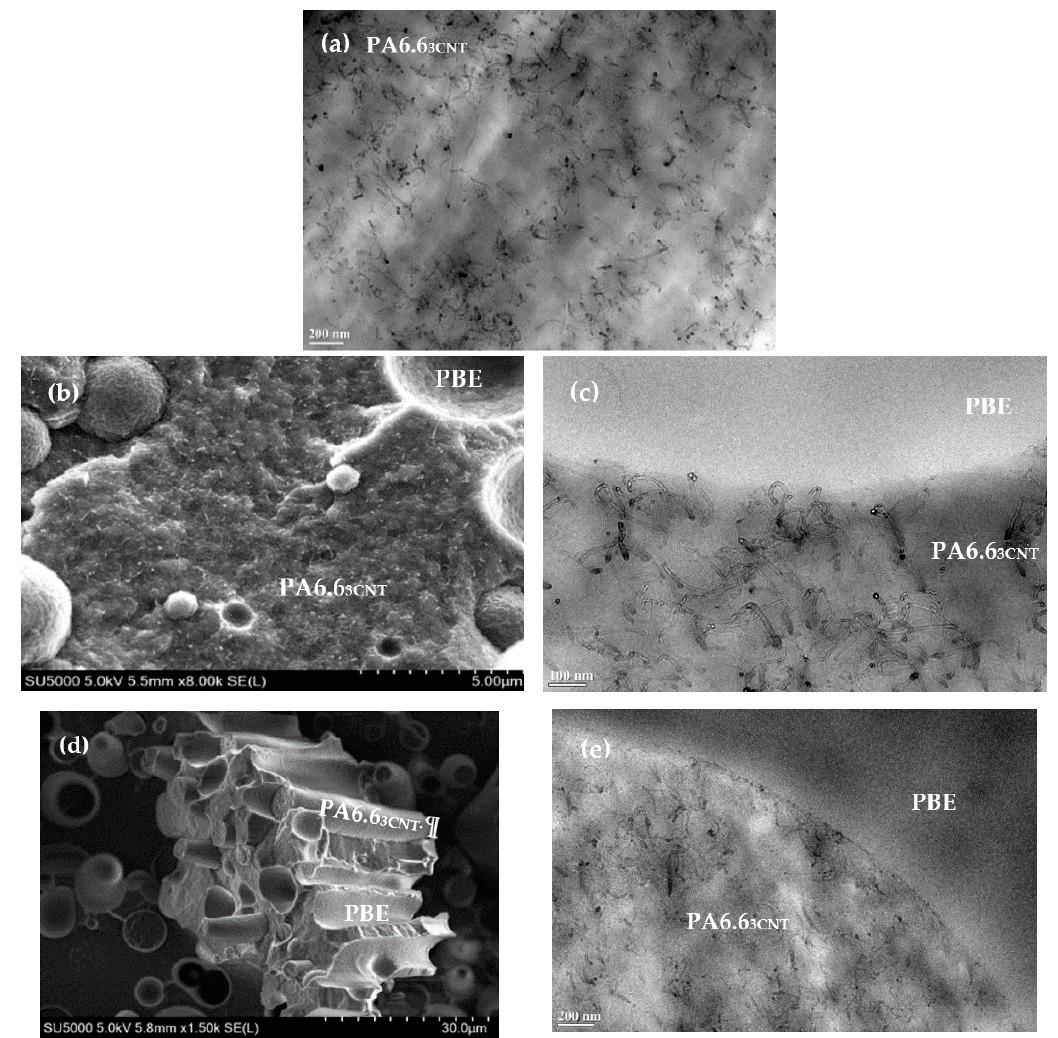
Figure 2. TEM images of PA6.6 3CNT ( a ) and SEM (left)/TEM (right) images of PA6.6 3CNT 90/PBE10 ( b , c ) PA6.6 3CNT 60/PBE40 ( d , e ) blends.